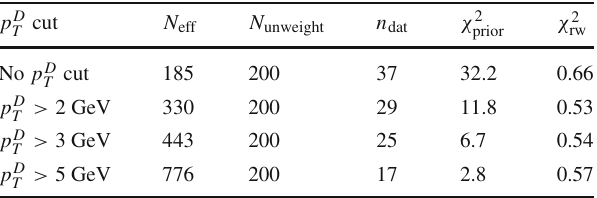
Table 7 Same as Table 6, now for varying cuts on the transverse momentum of the D 0 meson p D 0